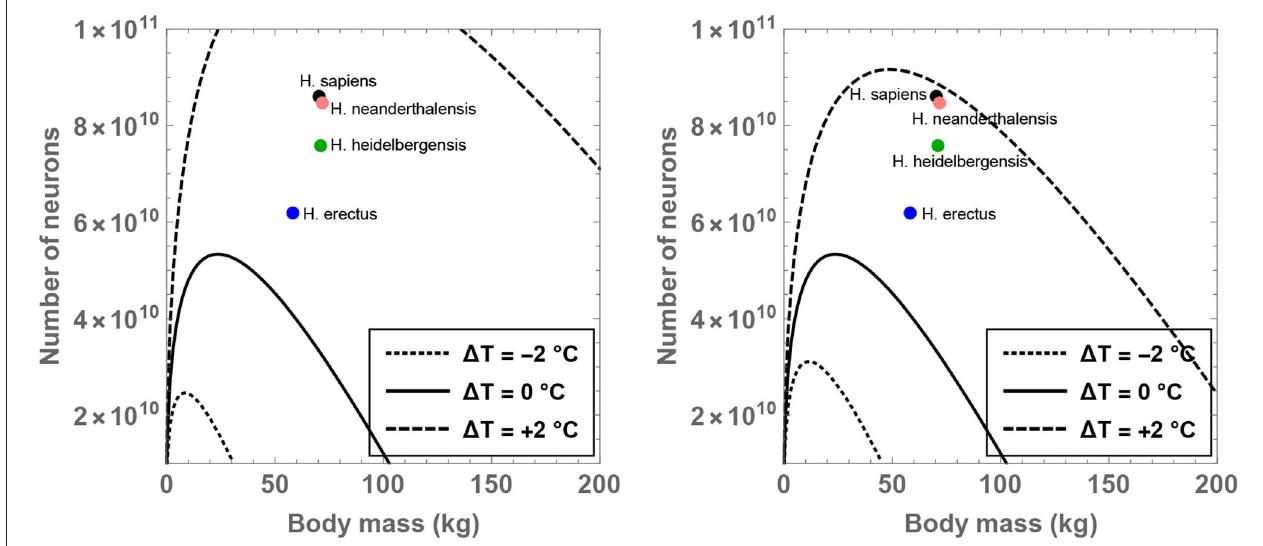
FIGURE 6 | Compatible combinations of the number of neurons ( N ) and body mass ( M BD ) are shown for putative primates that engage in 8 hours of feeding per day; regions below the curves represent the permitted values. The residual temperature ( 1 T ) quantifies the deviation of body temperature from the conventional value of 37 ◦ C. The left and right panels were derived using activation energies of 0.65 and 0.94 eV, respectively. The black, orange, green, and blue dots show the values of N and M BD for H. sapiens , H. neanderthalensis , H. heidelbergensis , and H. erectus ,